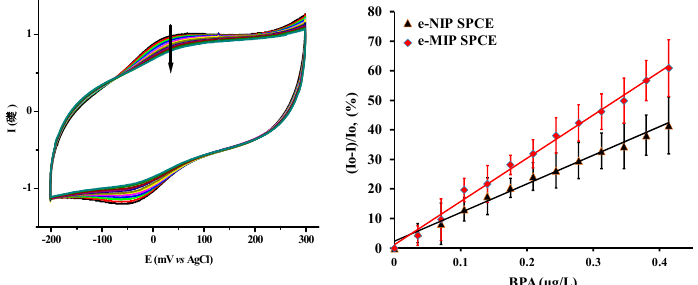
Figure 4. Cyclic voltamogramms of e-MIP-FcMMA-VP-EDMA-SPCE in KCl 0.1 M/water to increasing BPA concentration from 0 to 413 ng/L. Percentage decrease of anodic peak current obtained for both